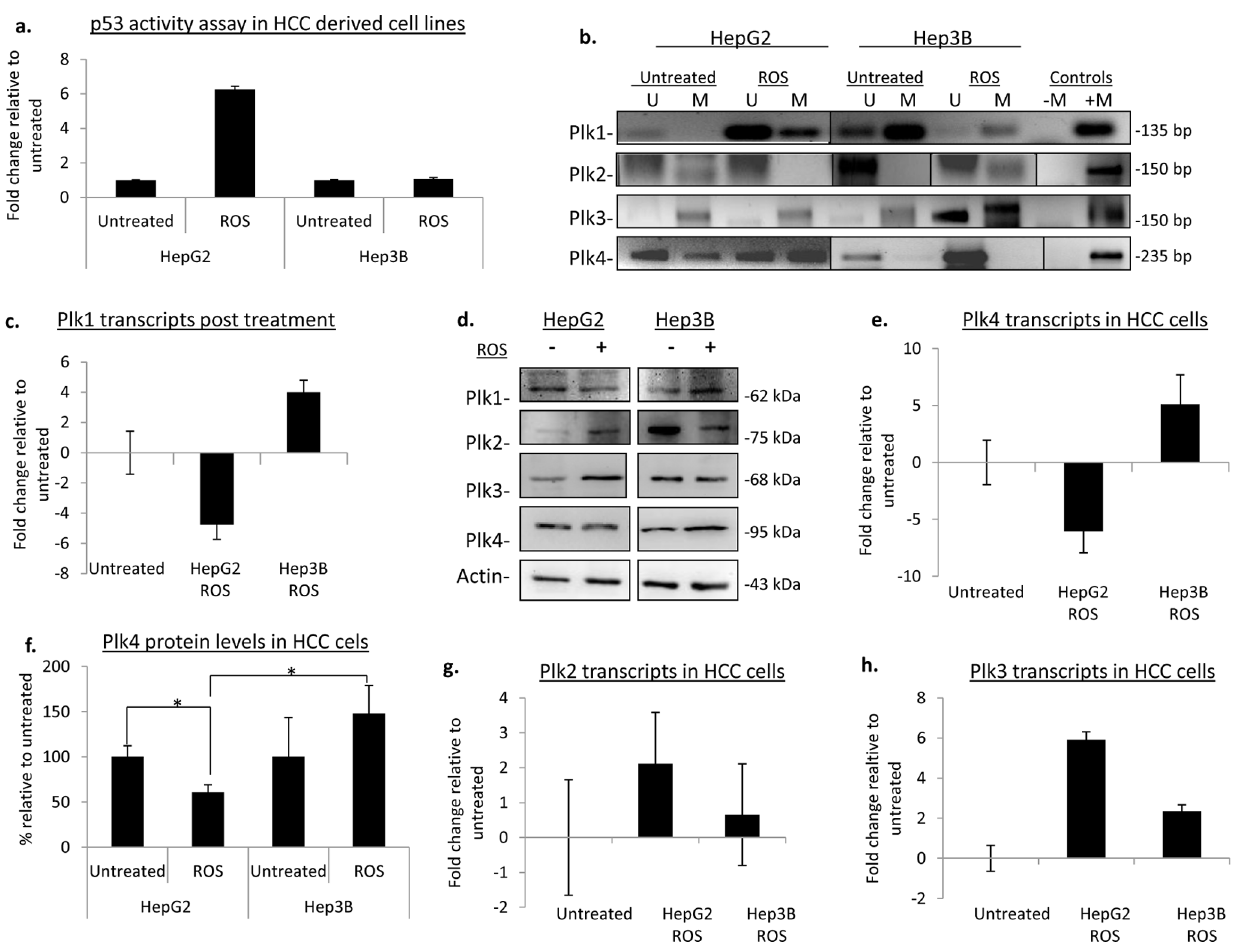
Figure 4. Modification of PLK promoter methylation marks in HCC cells exposed to ROS. (a) A p53 activity assay was performed to confirm activation of p53 with genotoxic stress caused by ROS. The percent activity is the average of three independent experiments with error bars representing the + / 2 SD. (b) MSP analysis of plk promoter methylation; U=unmethylated, M=methylated. Fully methylated HeLa DNA was used as a positive control ( + M), no template was added to the negative control ( 2 M). (c) Plk1 transcript levels were examined and normalized to the respective untreated samples. All qPCR data is representative of the mean value of three independent experiments and are normalized to the untreated samples. Error bars represent + / 2 SD. (d) Western blot analysis of PLK protein levels. Actin was used as a loading control. ( 2 ) represents the lysates from untreated cells, ( + ) lysates from cells were grown in the presence of ROS. (e) The fold change in plk4 transcripts from cells exposed to ROS. (f) Quantification of PLK4 protein levels. Data is representative of three independent experiments and the error bars represent + / 2 SD. * denotes significance with a p , 0.05. (g,h) PLK2 and PLK3 change in transcripts as determined by real time PCR.